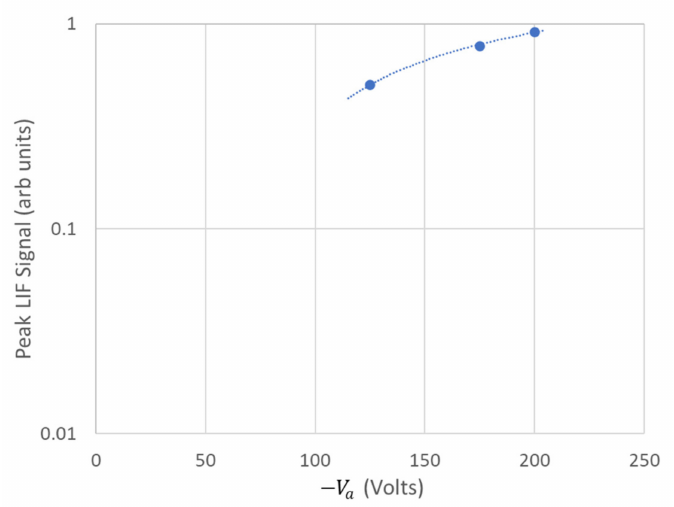
Figure 7. Effect of accelerator grid voltage on LIF signal at grid center for DTL28-H-H and DTLNEW throttle points (see Figure 5). Discharge chamber flow rates were